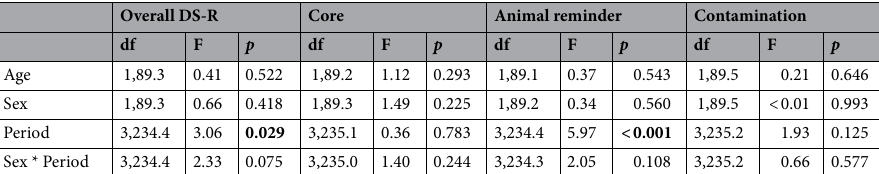
Table 1. The effects of fixed factors and covariates on disgust sensitivity changes; results of the linear mixed model. The variable “sex” refers to the sex of the fetus and the variable “period” refers to the time of measurement—in the 1st (T1), 2nd (T2), or 3rd (T3) trimester of pregnancy or after birth (T4). Significant values are in